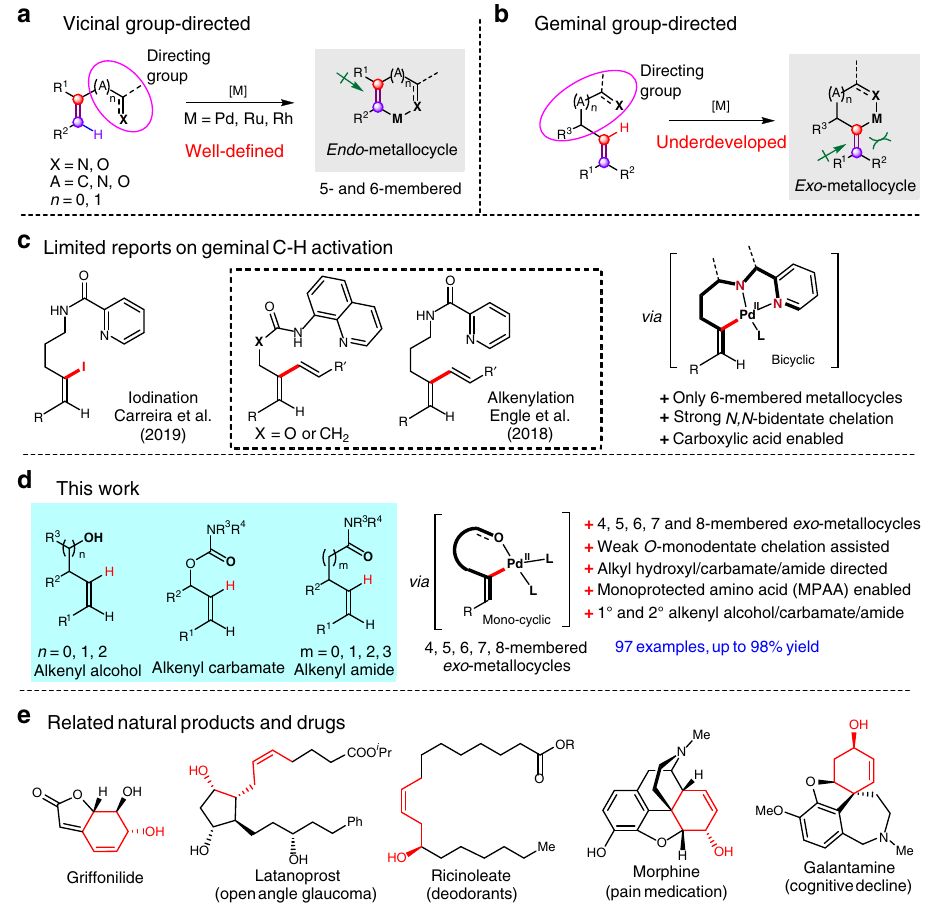
Fig. 1 Chelation-assisted ole fi nic C-H functionalization. a , b Type of group-directed ole fi nic C – H activation. c Reports on geminal ole fi nic C – H activation by bicyclic palladacycles. d Geminal ole fi nic C – H functionalization of alkenyl alcohols, carbamates and amides (this work). e Structurally related bioactive and natural